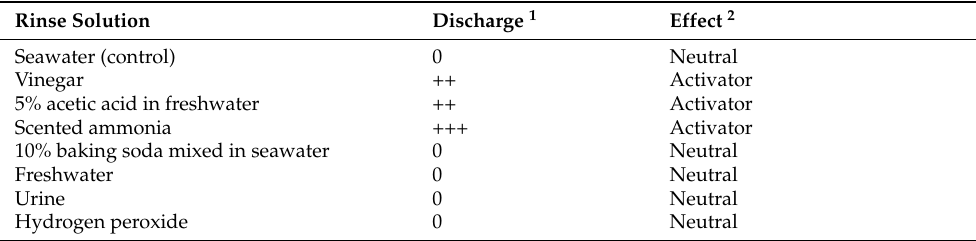
Table 1. Rhizostoma pulmo nematocyst response after the application of different rinse solutions com- monly recommended in first-aid protocols. The number of replicates was 10 for each rinse solution. Rinse